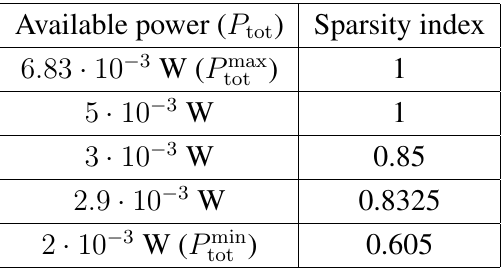
Table 4. Sparsity indexes of the adjacency matrix for the scenario presented in Figure 3b. Different values of overall network transmit power are